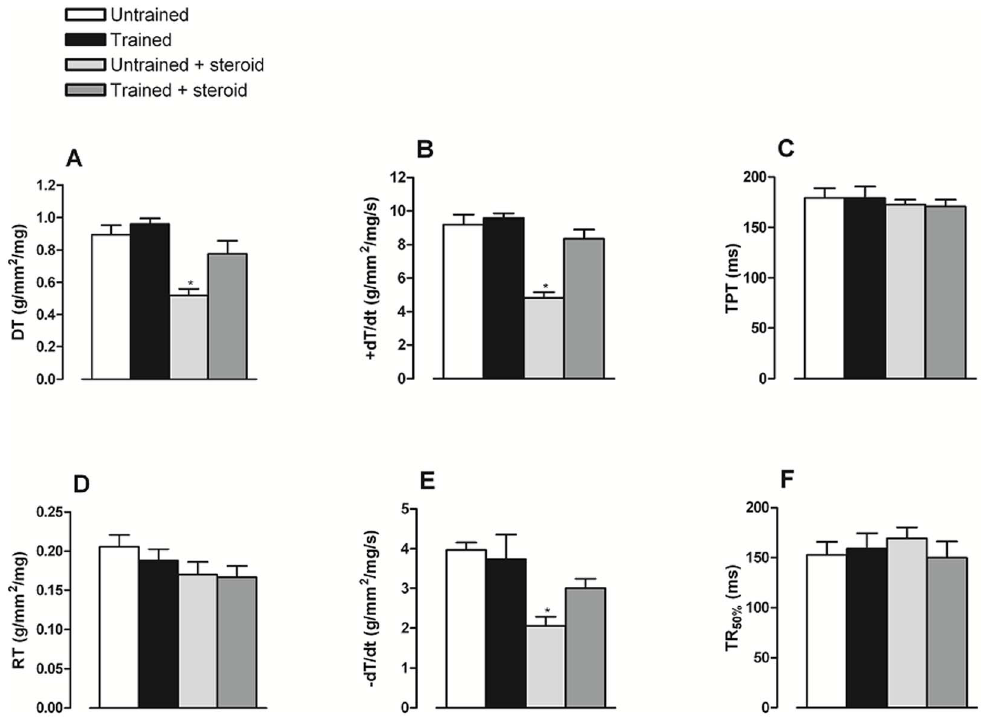
Figure 2. Systolic and diastolic parameters. Values are expressed as the mean 6 SEM of developed tension (DT, Panel A), maximum rate of tension development ( + dT/dt, Panel B), time to peak tension (TPT, Panel C), rest tension (RT, Panel D), maximum rate of tension decline ( 2 dT/dt, Panel E) and (TR 50% , Panel F). * represents significant differences (P , 0.05) respect to other groups by one-way ANOVA–Tukey test.